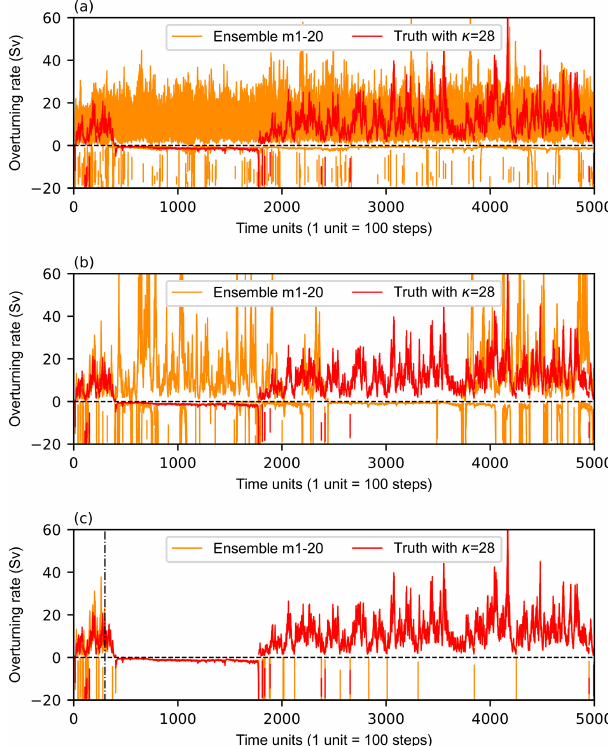
Figure 5. Time series of the overturning rate in the “truth” simu- lation with κ = 28 (red) and the individual ensemble members (or- ange) in the free model control ensemble simulations (a) without data assimilation and parameter estimation, (b) with data assimila- tion or (c) with data assimilation and parameter estimation using erroneously guessed κ values with a Gaussian perturbation that has a mean value of 32 and a standard deviation of 0.1. The dashed black line denoting v = 0 is a division line between the thermal- mode equilibrium state and the haline-mode equilibrium state. The dotted-dashed black line denoting the 300th unit marks the start of parameter